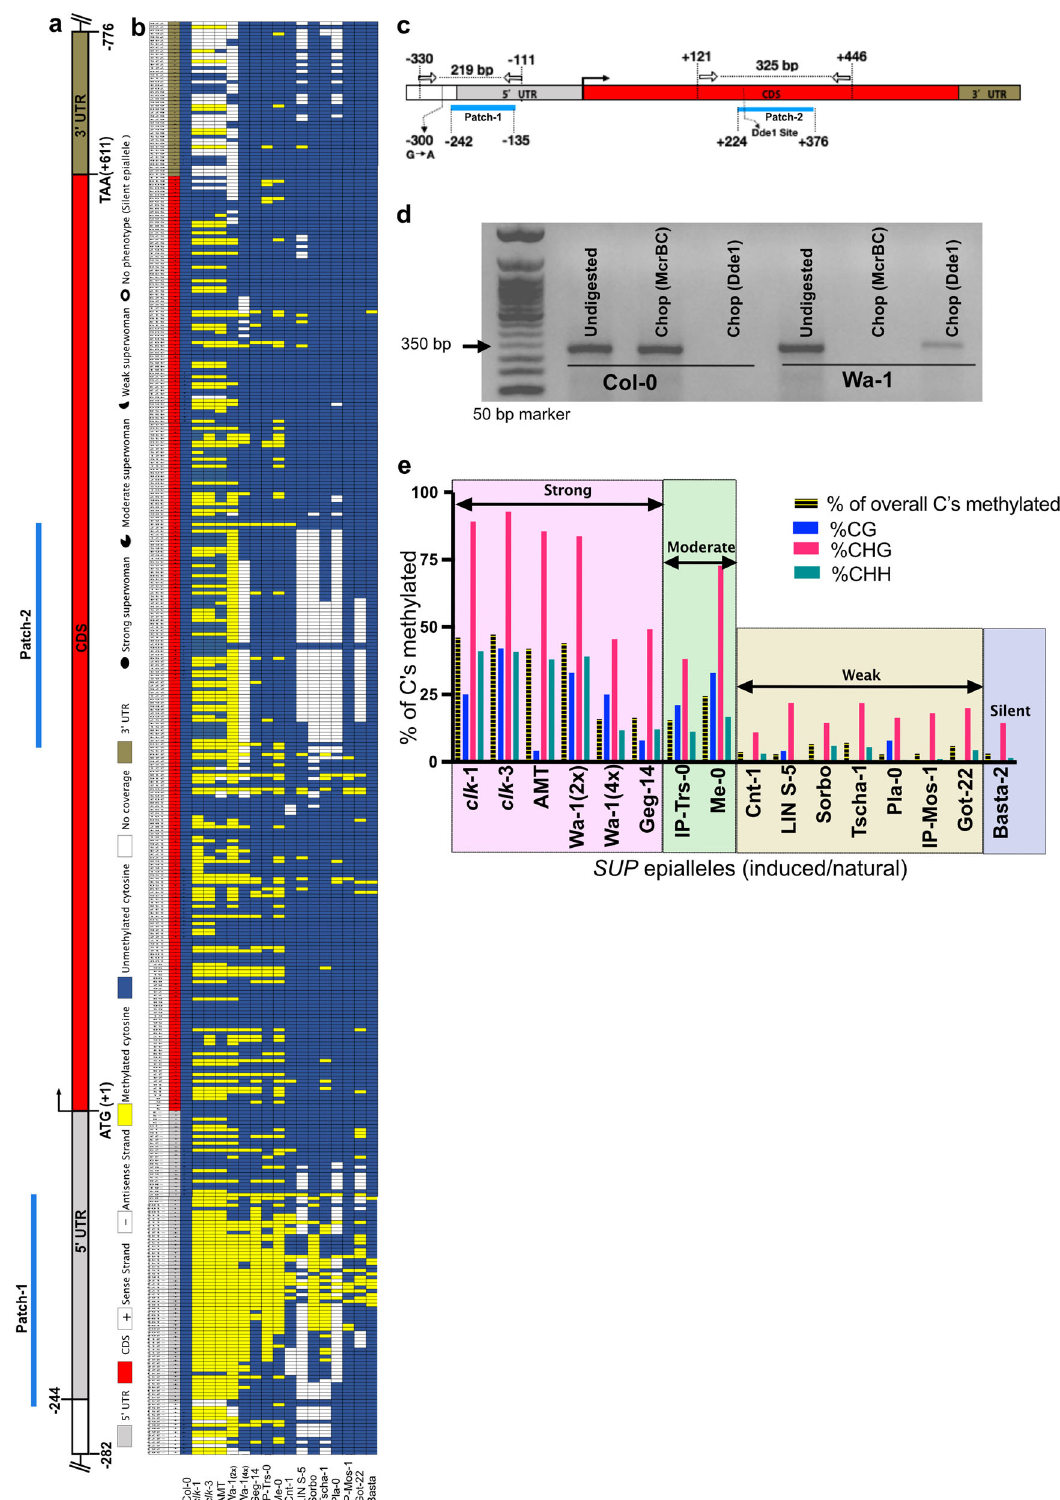
locus 19,43,44 . We chose a densely methylated region (patch-2) in SUP locus (Fig. 2a, c) in a way that it contains at least one cleavage site for two complementary MSREs: 1. McrBC (cleaves within the patch if any methylcytosine is preceded by a purine (A/ G) on one or both the strands when two such sites are separated by a distance of 40 – 3000 bp) and 2. Dde1 (protects the patch from cleavage when cytosine is methylated in its recognition